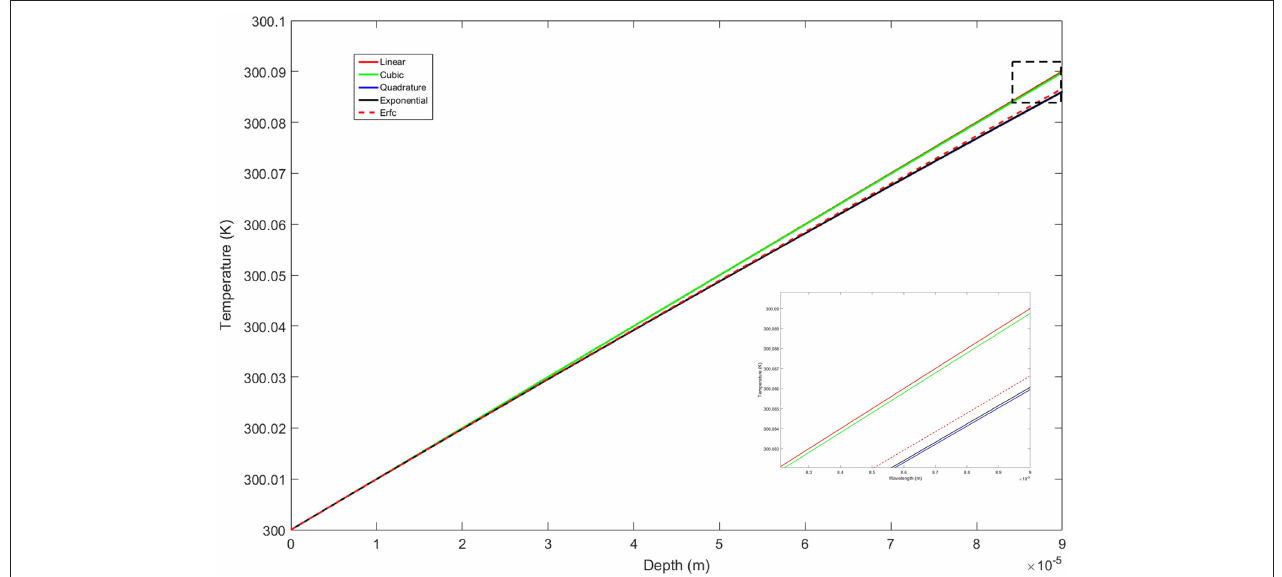
FIGURE 8 | Structure of the thermal boundary layers for fixed heat flux extending over the optical depths for both the mid- and long-wave thermal bands. The inset is of the dashed rectangle in the upper right of the curve and shows the hierarchy of the temperature profiles.